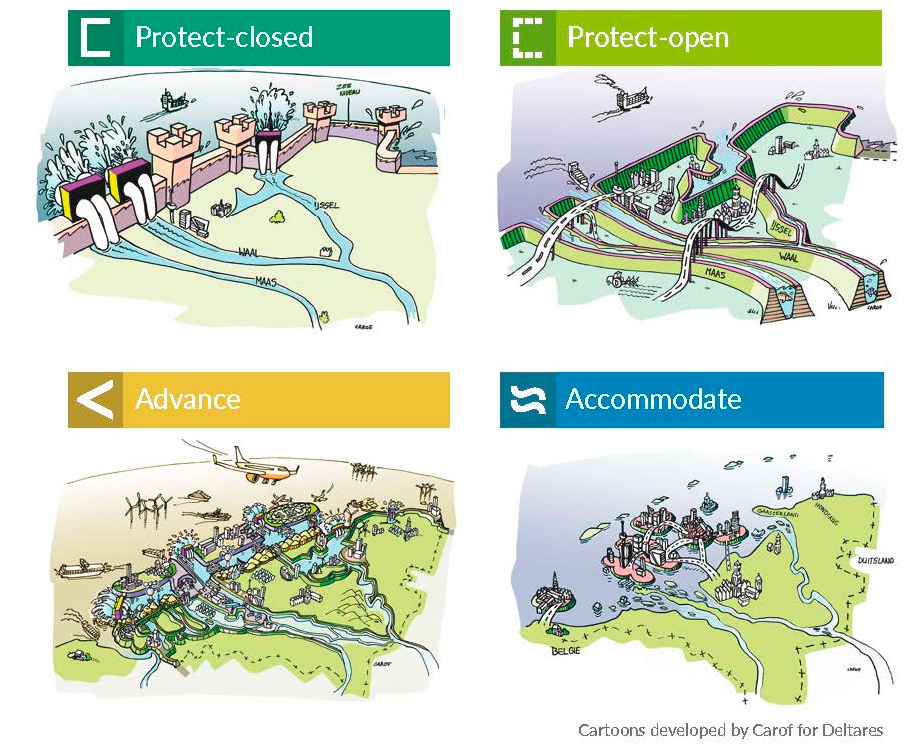
Figure 5. Potential types of strategies for the Netherlands to adapt to accelerated SLR (copyright of Carof, for Deltares).